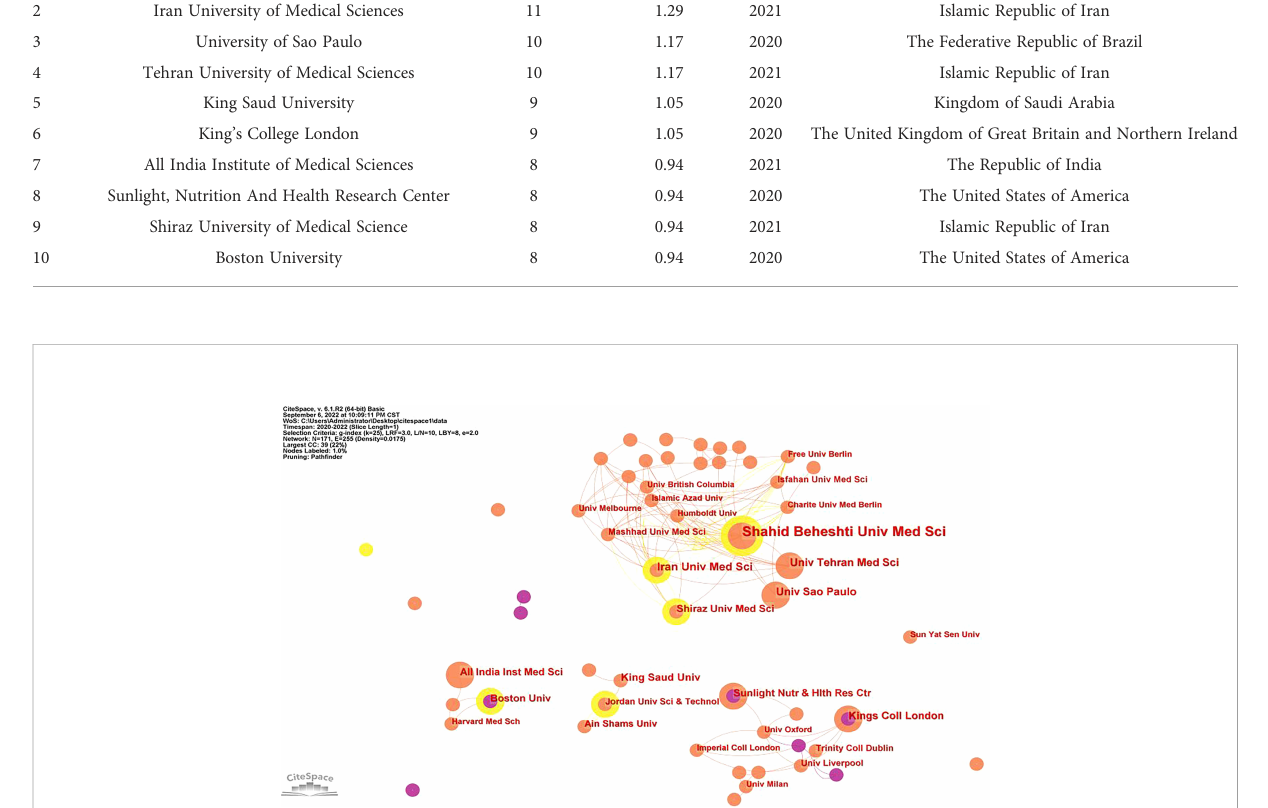
FIGURE 4 A network map showing institutional